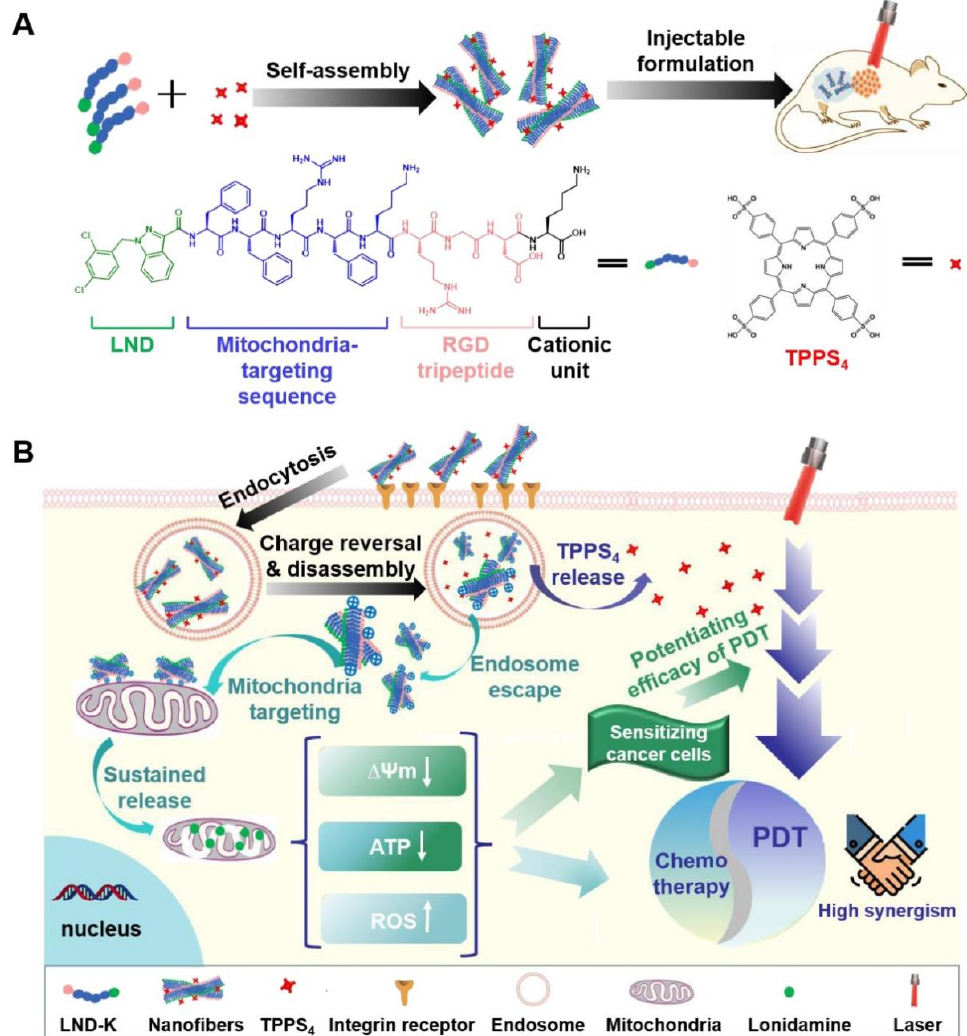
Figure 7. Schematic illustrations of self-assembled injectable hydrogels for combinational antitumor PDT-chemotherapy. ( A ) Injectable formulation of LND-K and TPPS 4 for PDT. ( B ) Synergistic cancer therapy achieved by utilizing the self-assembled injectable hydrogel. Reprinted with permission from [226].